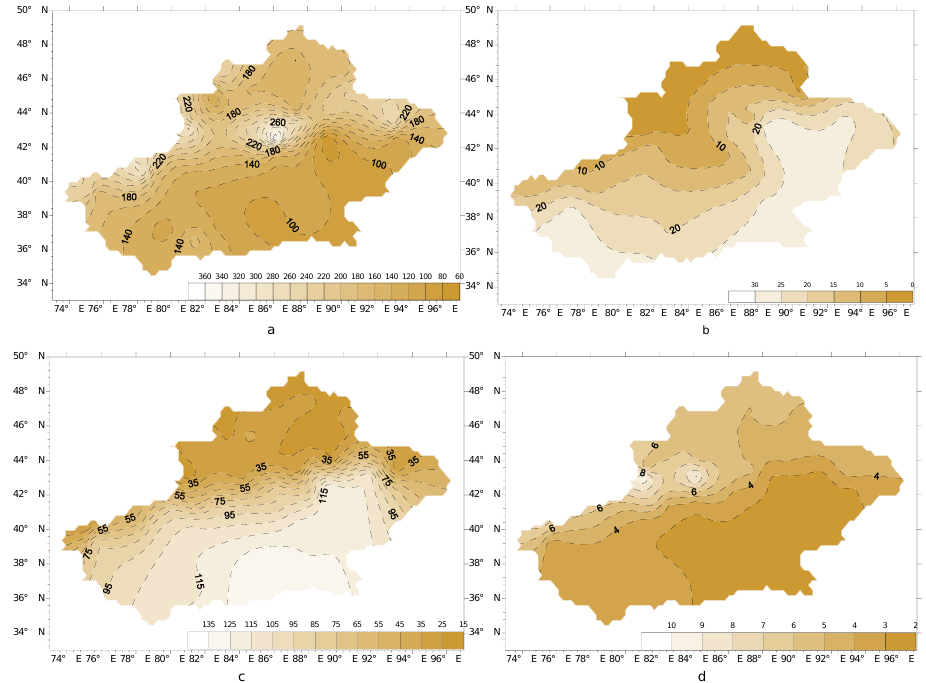
Figure 4 Fig. 4. Comparison of spatial distribution fits for (a) average annual precipitation, (b) drought index, (c) average CDD and (d) average CWD. Table 1. Comparison of fits from GEV, Gumbel and GPD models. GEV Gumbel stations